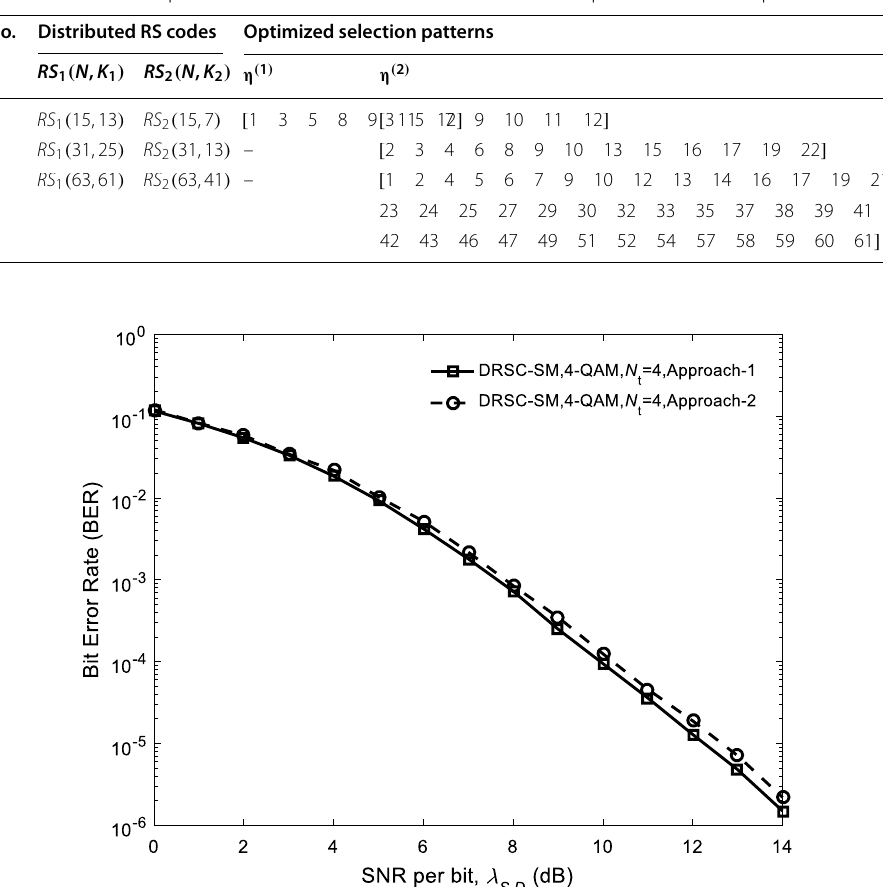
Fig. 5 Performance of DRSC-SM scheme (4-QAM) with RS 1 ( 15,13 ) and RS 2 ( 15,7 ) employing Approach 1 and Approach 2. The dashed line with circle mark denotes the BER performance of DRSC-SM scheme under Approach 2, and the solid line with square mark denotes the BER performance of DRSC-SM scheme under Approach